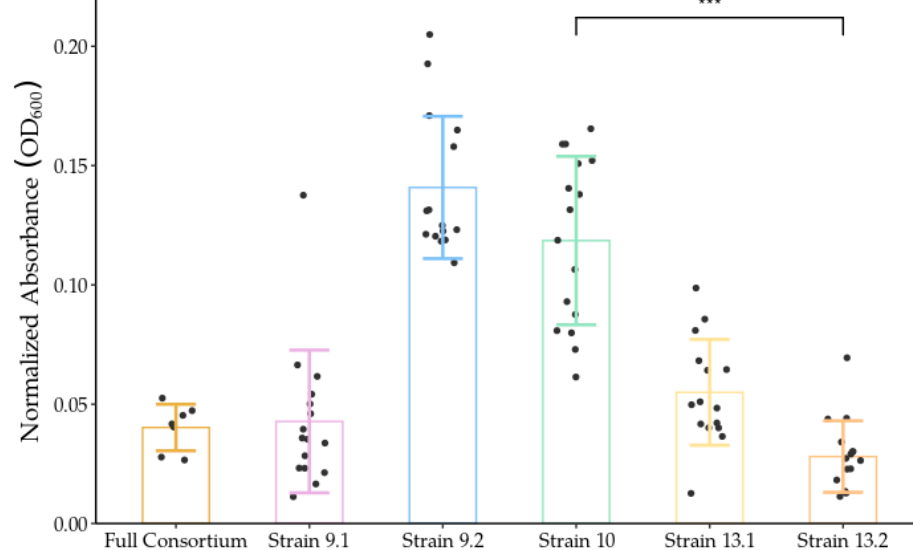
Figure 6. Quantification of biofilm production using crystal violet stain. Comparison of biofilm formation between the individual strains and the full consortium grown for 48 h on polystyrene 96- well plates. Biofilm production was quantified, minus background absorbance, by measuring optical density of biofilms stained with crystal violet at 600 nm using a TECAN infinite 200. *** p < 0.0001. Error bars denote one standard deviation from the mean.